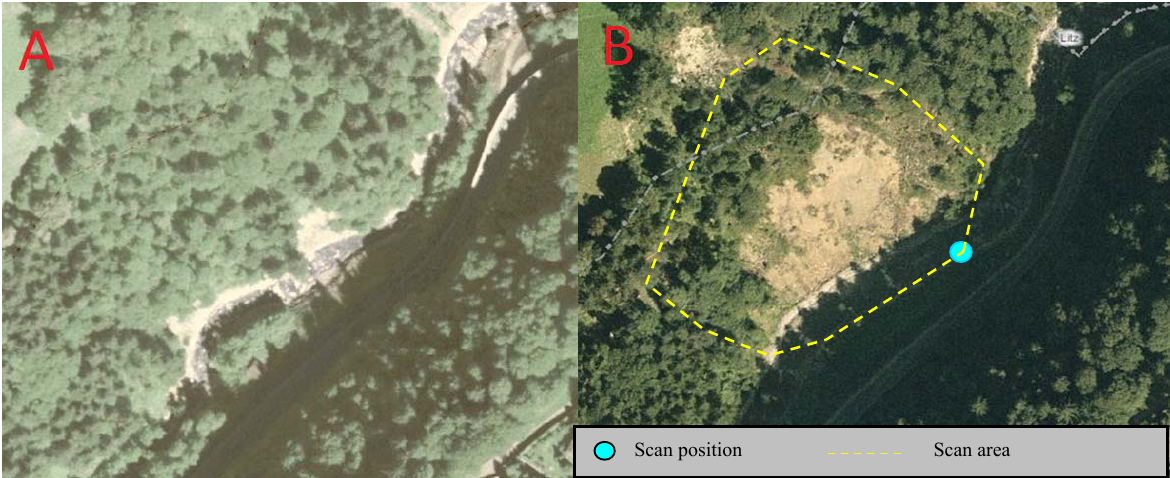
Figure 7. Aerial photos Galierm, 2001 ( A ) und 2006 ( B ); image source: © Land Vorarlberg, http://vogis.cnv.at.